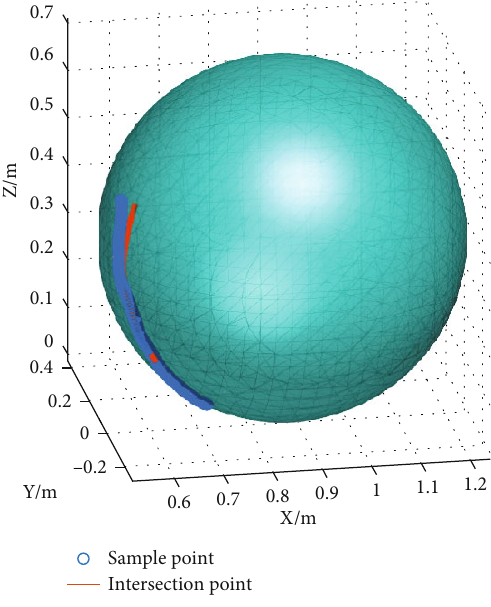
Figure 5: Sphere- fi tting